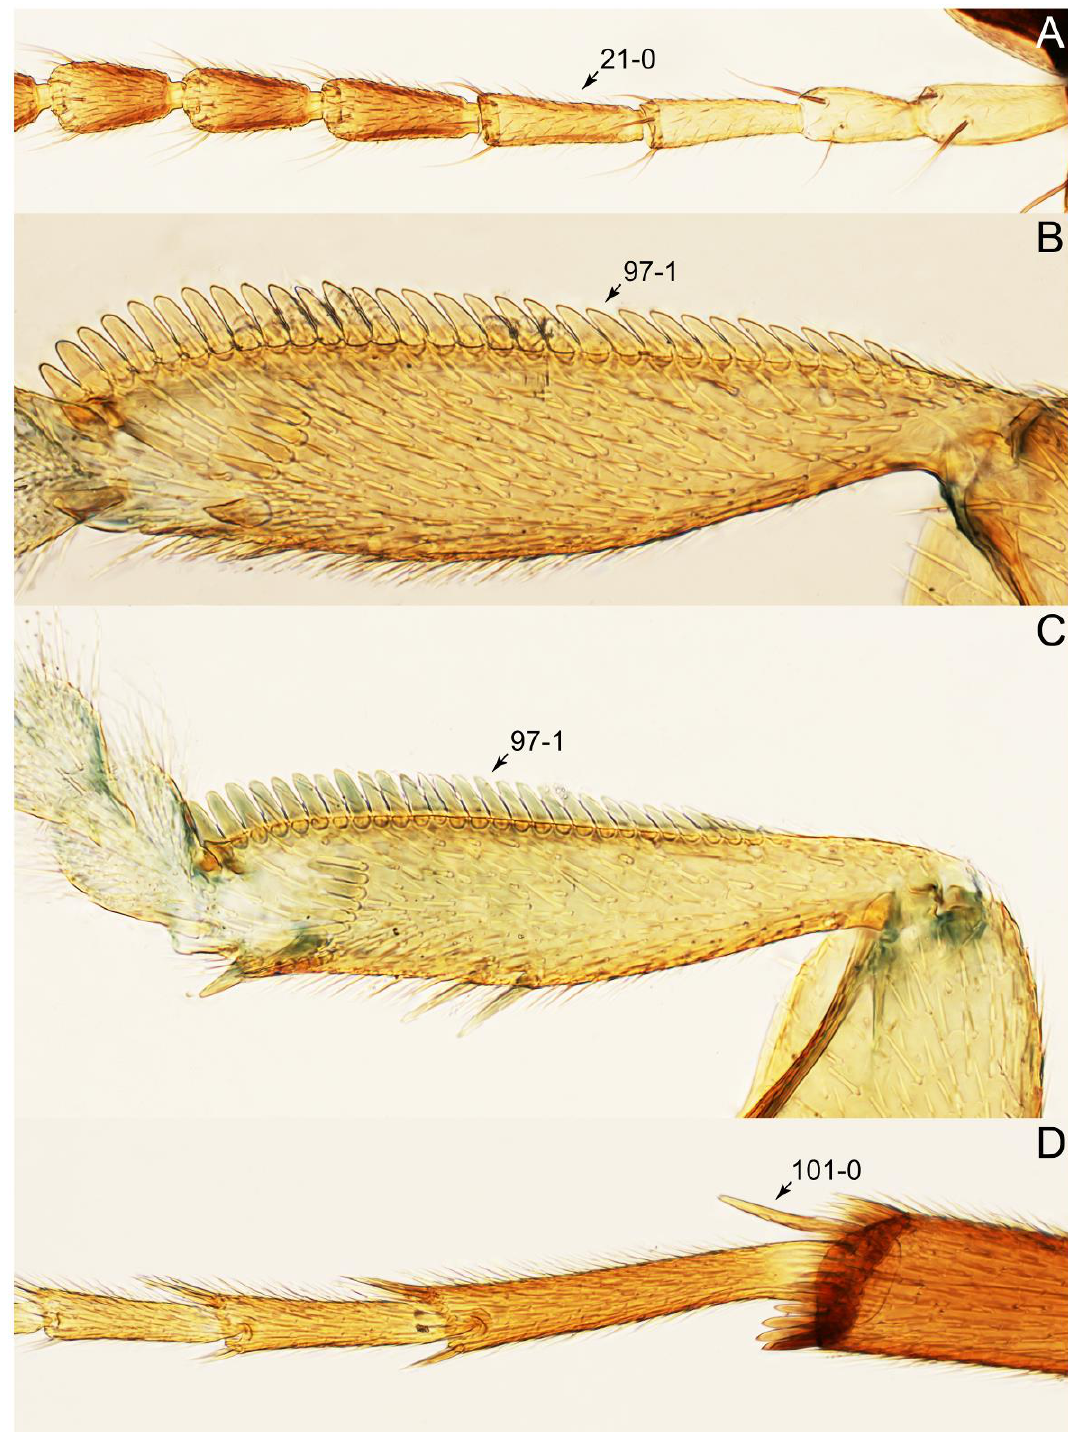
Figure 17. Photographs of body parts of Tachyporini: Euconosomatina, enlarged, dorsal view. ( A ) antenna of Sepedophilus littoreus . ( B ) protibia of Sepedophilus bisignatus . ( C ) protibia of Sepedophilus cinctulus . ( D ) metatarsus and metatibial spines of Sepedophilus crassus . Characters and character states (format X-X) are indicated on each